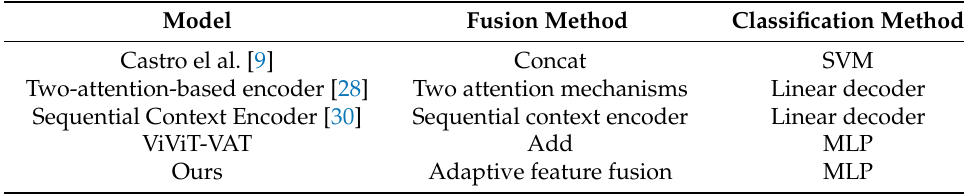
Table 3. The differences between the proposed model and the baseline model are compared. Two attention mechanisms refer to inter-segment inter-modal attention and intra-segment inter-modal attention, SVM refers to support vector machine, and MLP refers to multi-layer perceptron.